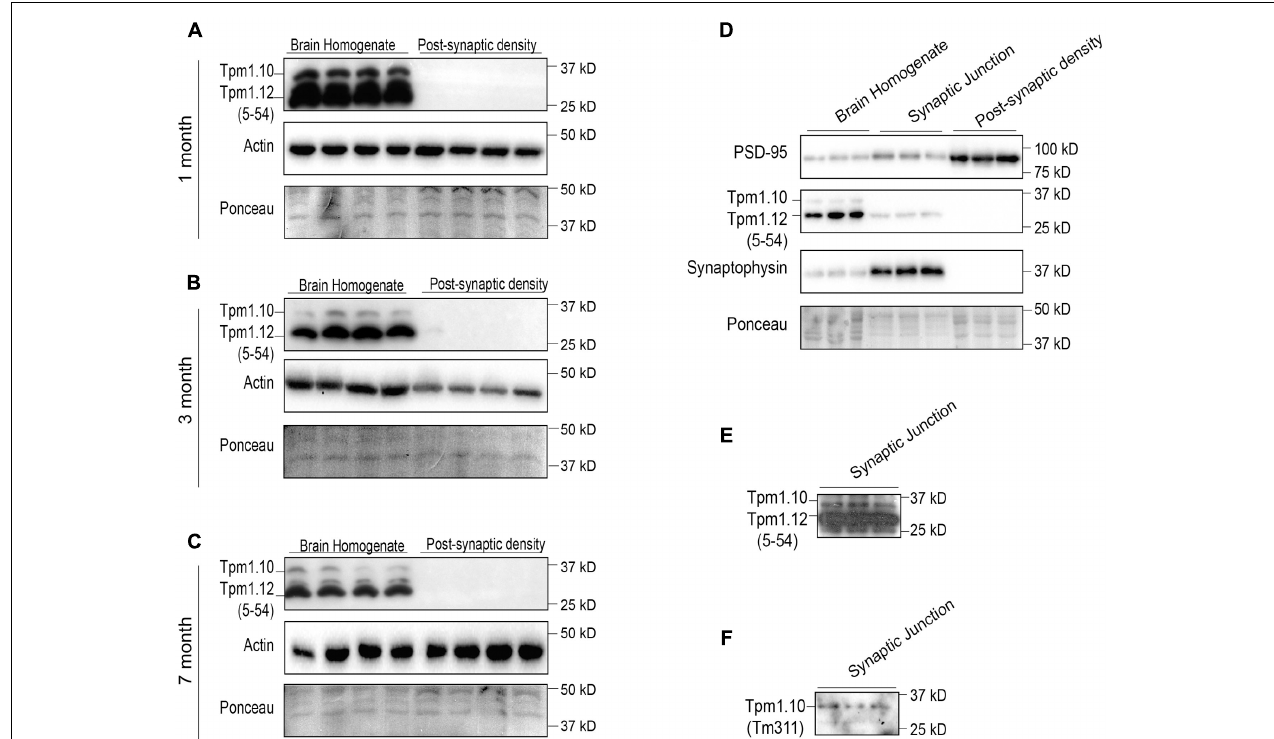
FIGURE 3 | Expression profile of tropomyosin (Tpm) isoforms Tpm1.10 and Tpm1.12 (utilizing the 5–54 and Tm311 antibodies) in the brain homogenate (BH) and post-synaptic density (PSD) of wild type mouse brains. Western blot of 1-month (A) , 3-months (B) , and 7-months (C) brain homogenate and post-synaptic densities show localization of Tpm1.12 in the brain homogenate, but not the post-synaptic compartment throughout the age groups. Total actin and Ponceau staining of blots demonstrates equal loading. (D) Western blot analysis of the immunoreactivity for Tpm1.10 and Tpm1.12 in the brain homogenate, synaptic junction and post-synaptic compartment of 3-months-old wild-type mice. (E) Due to the poor Tpm1.10 signal in the synaptic junction, the membrane was overexposed to detect Tpm1.10 expression. (F) To confirm the specificity of the Tpm1.10 signal in (E) the Tm311 antibody, which detects Tpm1.10 but not Tpm1.12 was used, indicating immunoreactivity for Tpm1.10 in the synaptic